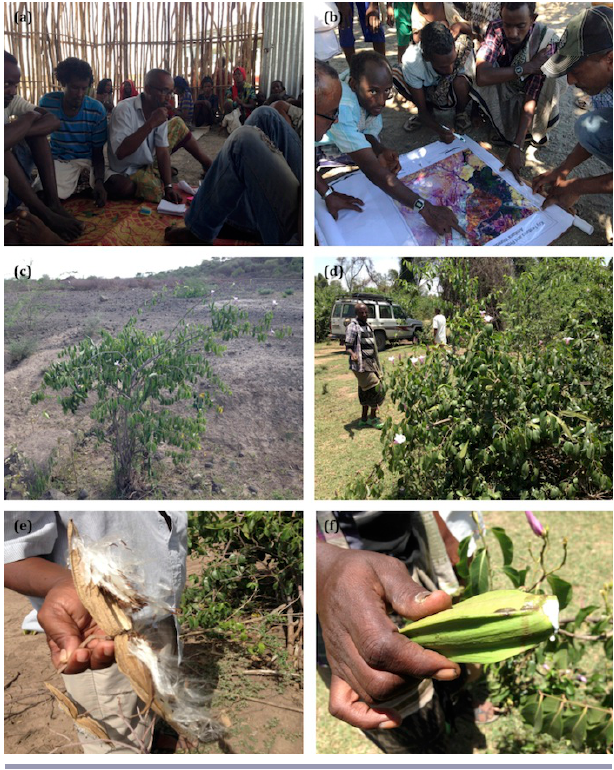
Fig. 1 . Local ecological knowledge integration process with Afar pastoralists and rubber vine negative impacts. (a) Focus group with pastoralists, which revealed the greatest threats to local livelihoods, changes witnessed on the landscape, and growing concerns regarding rubber vine. (b) Afar pastoralists identifying invasive plants with the assistance of Landsat 8 satellite imagery during participatory mapping activities. (c) Rubber vine growing in shrub form in a disturbed area adjacent to a cotton field. (d) Participatory field data collection with pastoralists, including collection of rubber vine occurrence points for the risk assessment model. Rubber vine growing in shrub form (foreground). Other vines growing in tree canopies in the background, with the Awash River behind the vehicle. (e) Dried rubber vine seedpod revealing thousands of pappus seeds, which are easily distributed by wind and water. (f) Immature seed pod dripping milky latex sap. The sap is poisonous if ingested by livestock and is a skin irritant. All images courtesy of M.